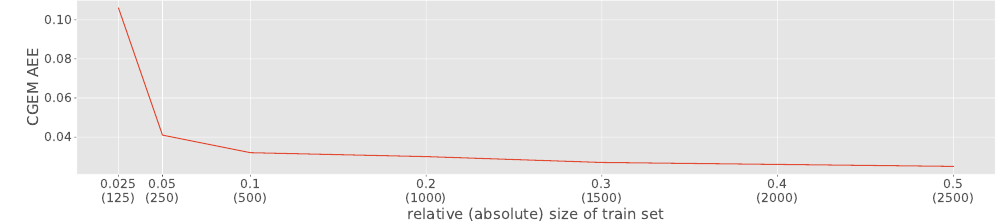
Figure 8. Evaluation of CGEM for different train/test split ratios for GLVQ classifier on OUTDOOR data set (total of 5000